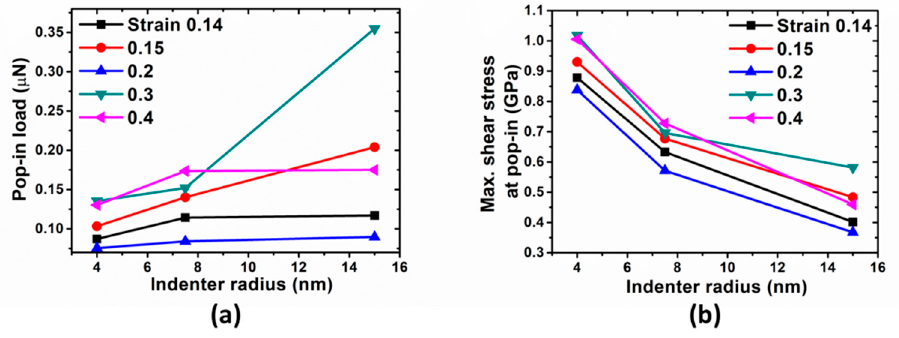
Figure 9. ( a ) Pop-in loads and ( b ) corresponding maximum shear stresses as a function of indenter radius with various strain levels.